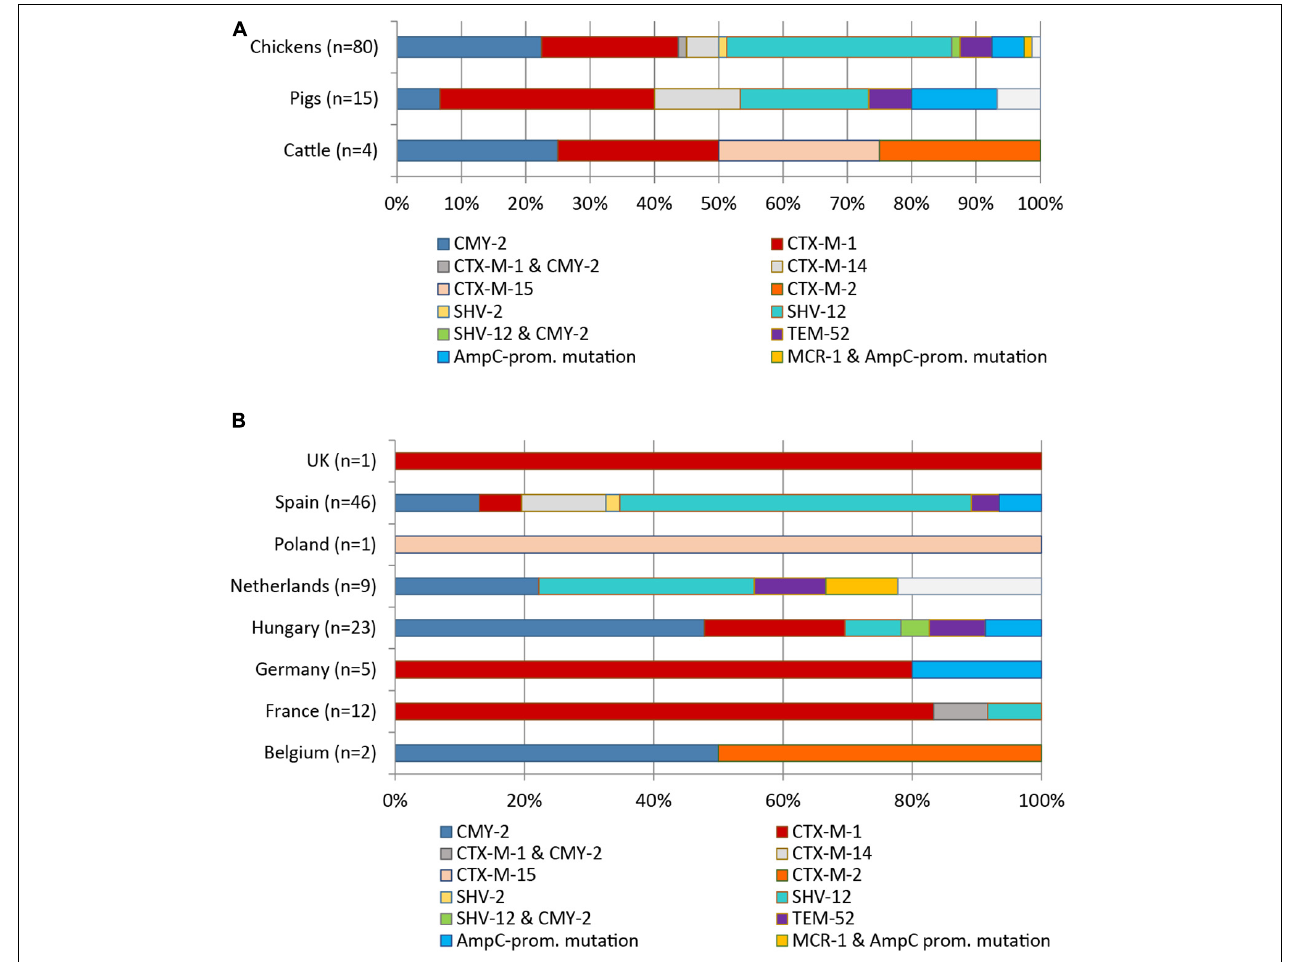
FIGURE 1 | Distribution of ESBL/pAmpC genes and AmpC promotor mutations among 99 ESC-non-S/ESC-R E. coli isolates with regard to livestock species (A) and country of origin (B) .